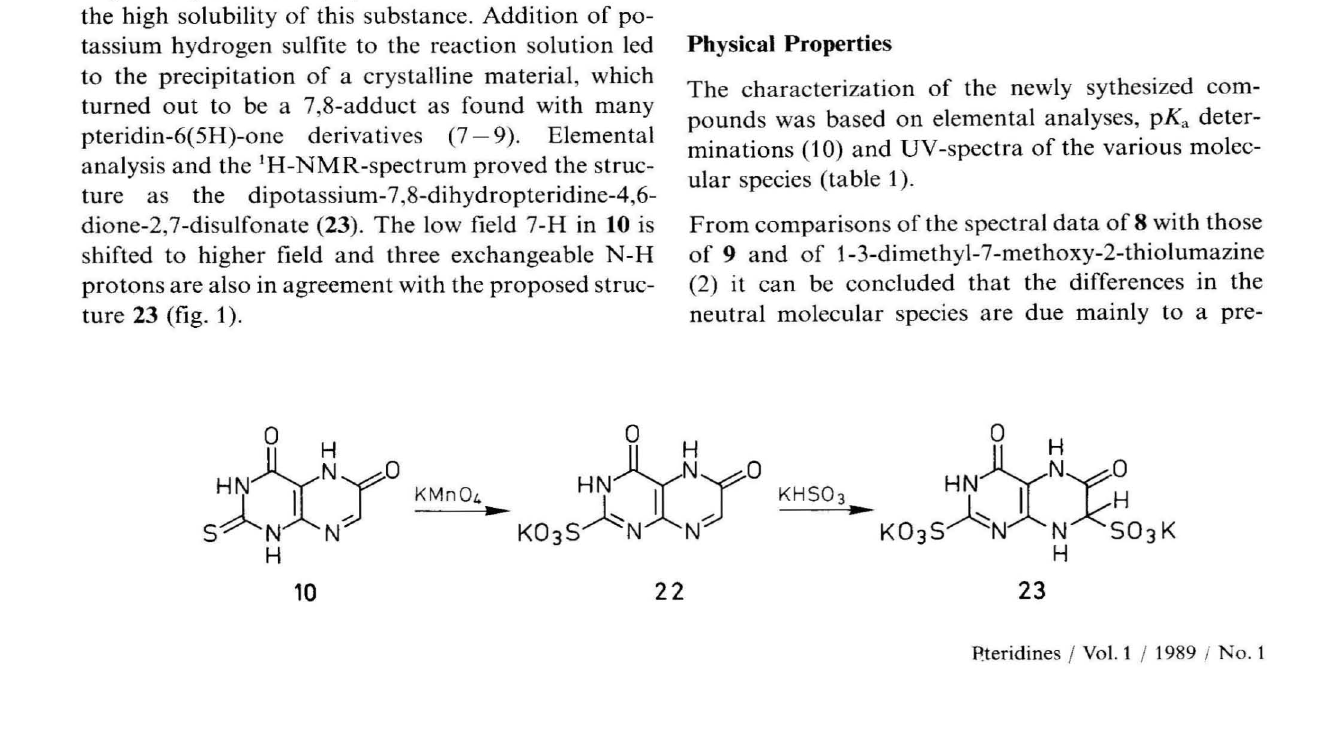
Figure 1. 'H-NMR-Spectra of 23 in D6-DMSO and after D 2 0